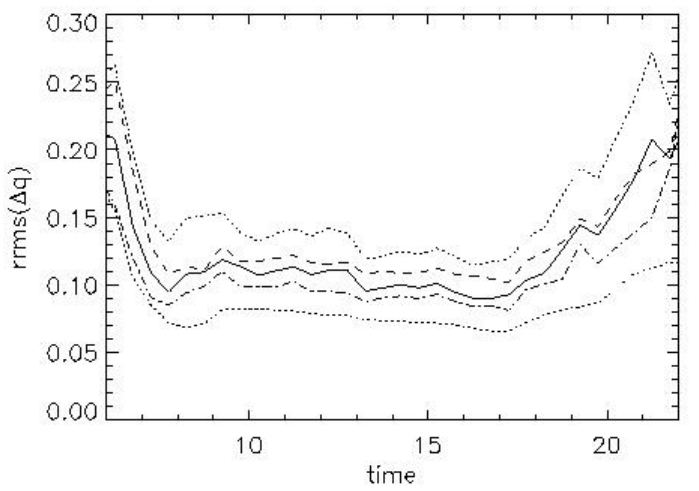
Figure 8. The relative root mean square of volume residuals with respect to link averages (dotted line at the top), within classified groups (dashed line), within clusters (solid line), within classified groups for which seasonal variations have been taken into account (dashed dotted line), and the rrms of the noise (dotted line at the